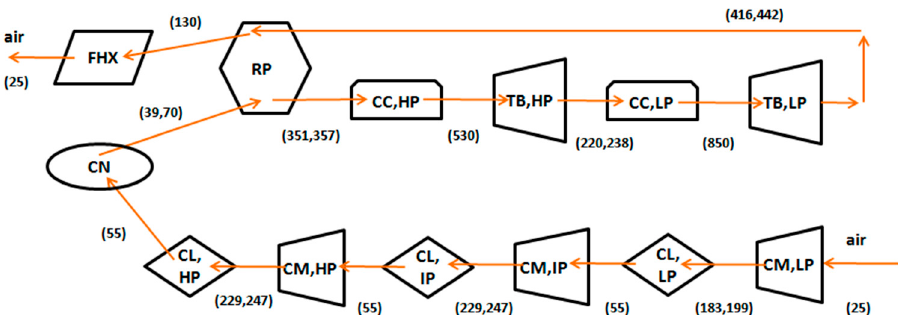
Figure A1. Temperature range of the conventional CAES system in the base case scenario. Values in each bracket show minimum and maximum temperature. The cavern operates between 5 and 7 MPa. All compression stages and expansion stages have equal pressure ratios.